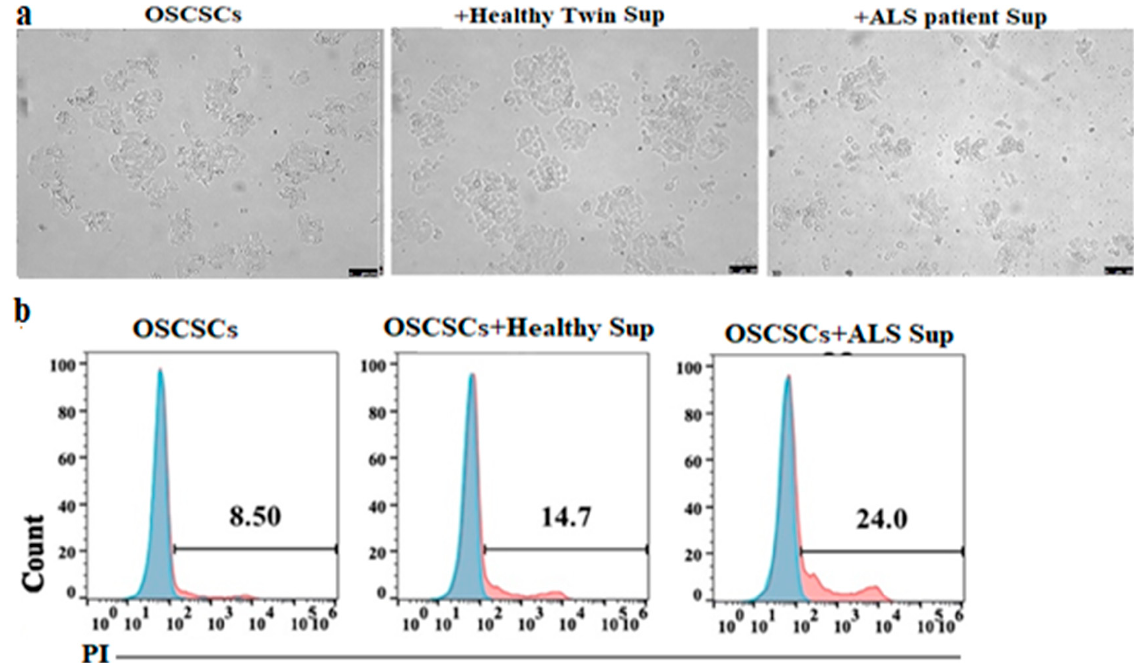
Figure 7. Supernatants from CD8+ T cells from ALS patients induced higher cell death of OSCSCs. CD8+ T cells of healthy individuals and ALS patients were isolated from PBMCs as described in Section 2. CD8+T cells (1 × 10 6 cells/mL) were treated with a combination of IL-2 (100 U/mL) and anti-CD3/28 antibody (25 µL/mL) before the supernatants were harvested to determine IFN- γ secretion using single ELISA. Supernatants containing IFN- γ from the healthy individuals and ALS patients’ CD8+ T cells were added to the same numbers of OSCSCs cultured in the plates for 2 days. On day 2, pictures of culture plates were taken using inverse microscope ( a ), OSCSCs were detached and the levels of cell death was determined using propidium iodide staining by flow cytometry ( b ). One of six representative experiments is shown in the figure.